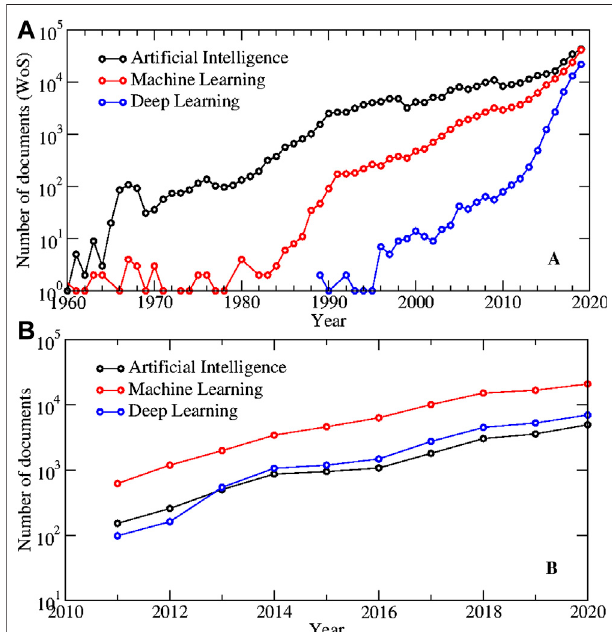
FIGURE 1 | Growth of the number of documents related to arti fi cial intelligence in (A) the WoS and (B) Dimensions. (A) Between 1990 and 2010, the growth seems exponential with a doubling time of 8 years for arti fi cial intelligenceand3.5 yearsformachinelearning.Inmore recentyears, the growth is even faster. Number of documents obtained in the Web of Science with the terms “ arti fi cial intelligence, ” “ machine learning, ” and “ deep learning. ” (B) Thenumber ofdocuments identi fi ed inany Frontiersjournal also shows an exponential growth with a doubling time smaller than 2 years. Number of documents obtained in Dimensions with the terms “ arti fi cial intelligence, ” “ machine learning, ” and “ deep learning ” and fi ltering by Frontiers journals.